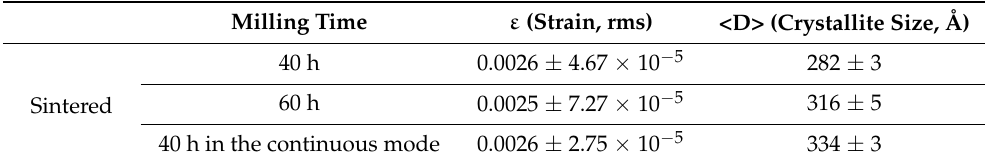
Table 6. Variation in crystallite size <D> and lattice strain ( ε ) of β phase for the sintered Ti-35Nb-6Mo alloys.